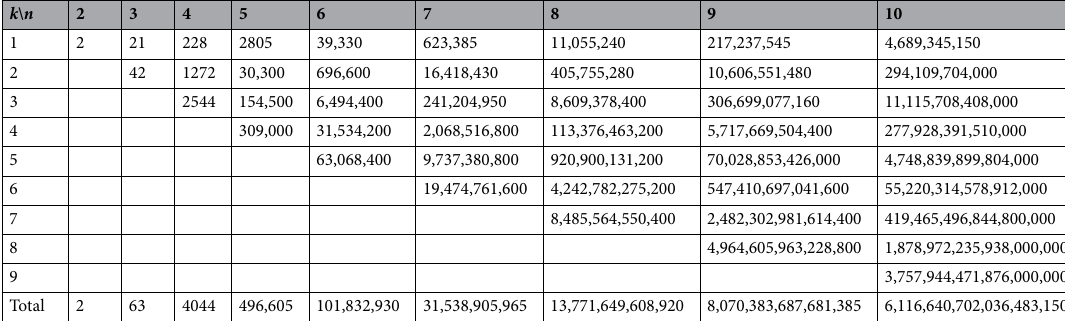
Table 1. Counts of TCNs with k reticulations on [ n ], where 1 the total numbers of